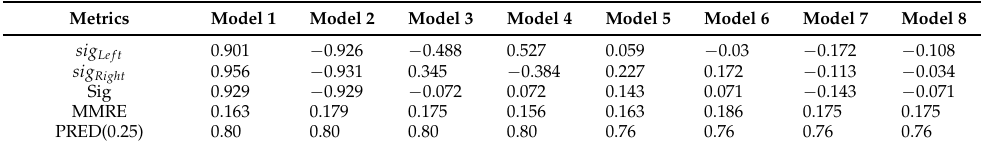
Table 3. The summary of the sig values among the eight